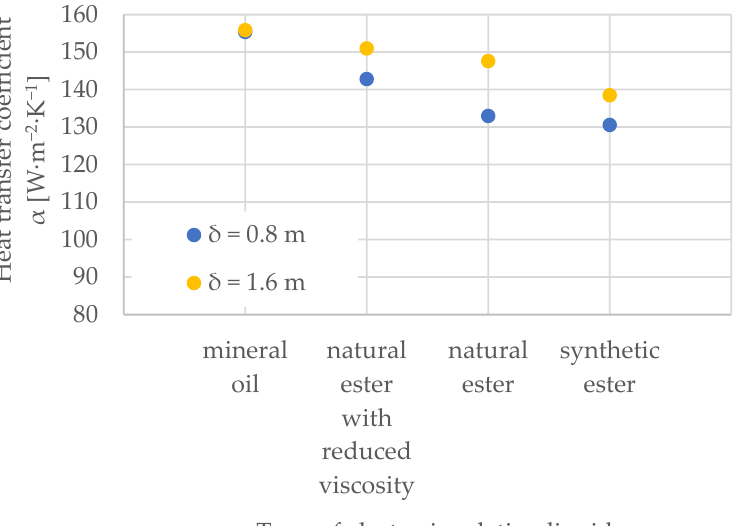
Figure 7. The heat transfer coefficient α depending on the type of electrical insulation liquid, for different values of the length of the heating element δ, and the value of the heat load of the cooled surface q = 3000 W·m − 2 .